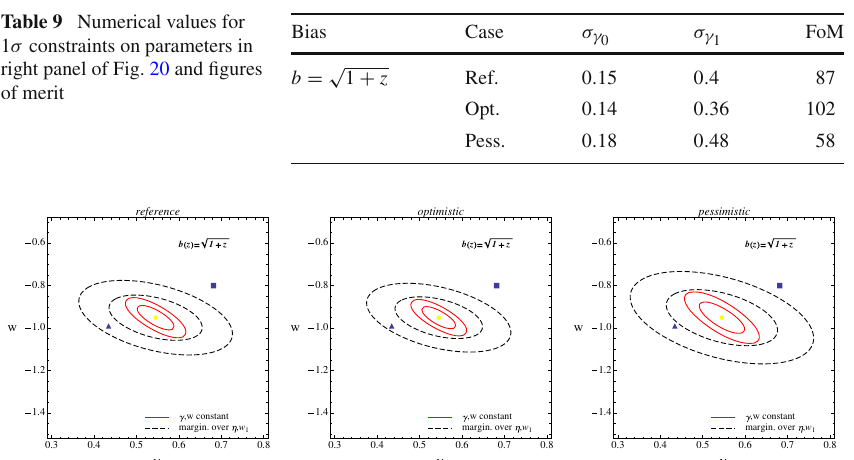
Fig. 22 η -parameterization. 1 and 2 σ marginalized probability regions obtained assuming constant γ and w (red solid curves) or assuming the parameterizations (I.8.6) and (I.8.2) and marginalizing over η and w (black dashed curves); marginalized error values are in columns σ γ represent the fiducial model, the triangles stand for a f ( R ) model and the squares mark the flat DGP Table 10 Numerical values for 1 σ constraints on parameters in Fig. 23 and figures of